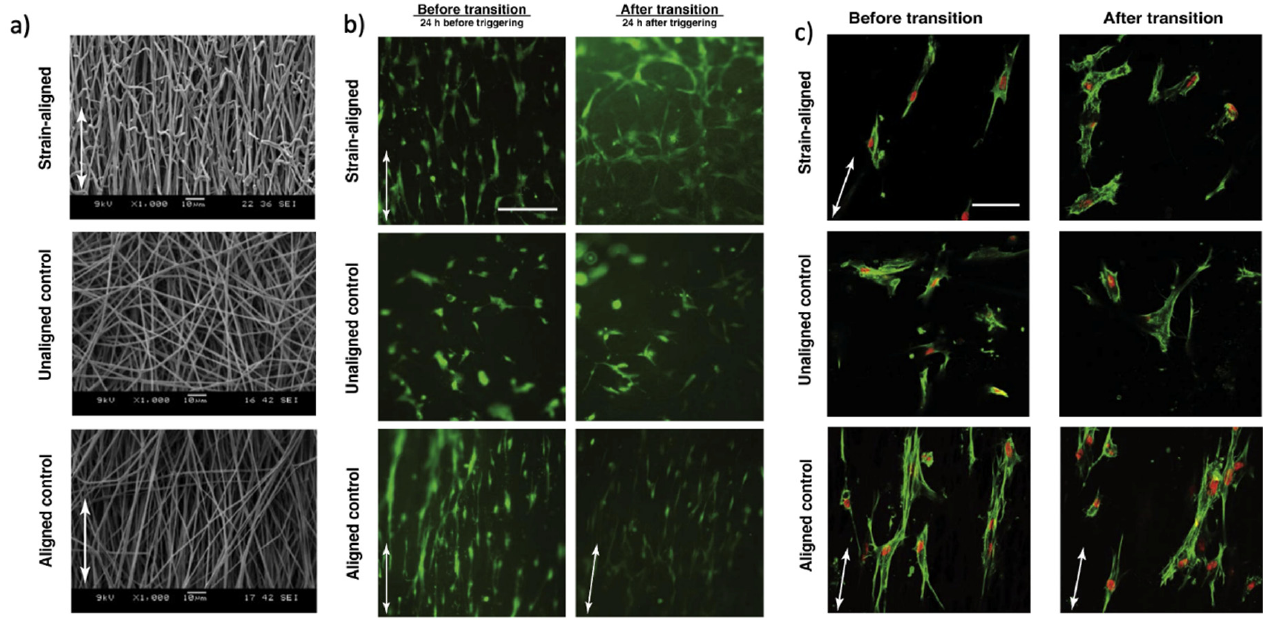
Figure 8. ( a ) The SEM images show the fiber alignment in the direction of applied strain following programming; ( b ) high cell viability before and after changes in the scaffold architecture; and ( c ) cell morphology and nuclear alignment changes after scaffold fiber alignment change (Reprinted with permission from ref. [33]. Copyright 2013 Elsevier). Table 2. A summary of recent studies on the regulation of cell behaviors using biomimetic SMP nanofibers. Research Group